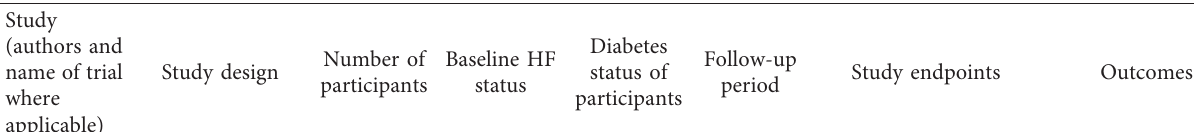
Figure 7: Subgroup analysis of the treatment effect SGLT2 inhibitors on cardiovascular death depending on baseline diabetes status. Table 2: Review of studies on SGLT2 and LV